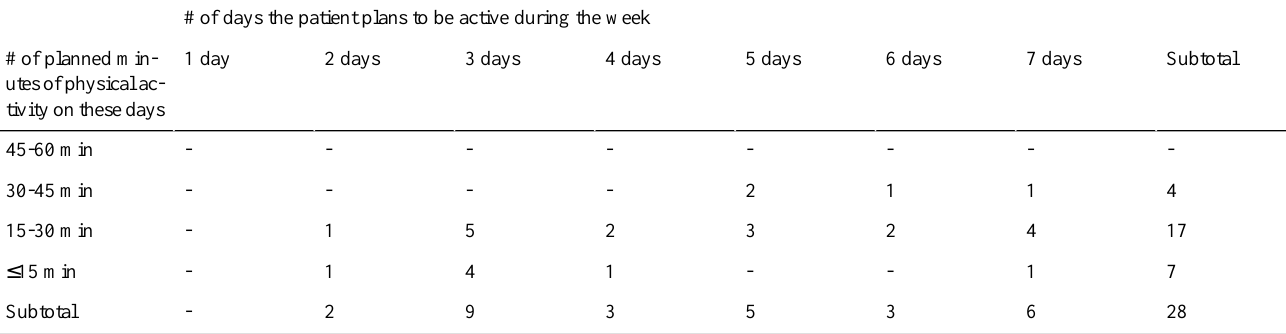
Table 5. Distribution of low-salt diet goals reached when patients became adherent (N=36).